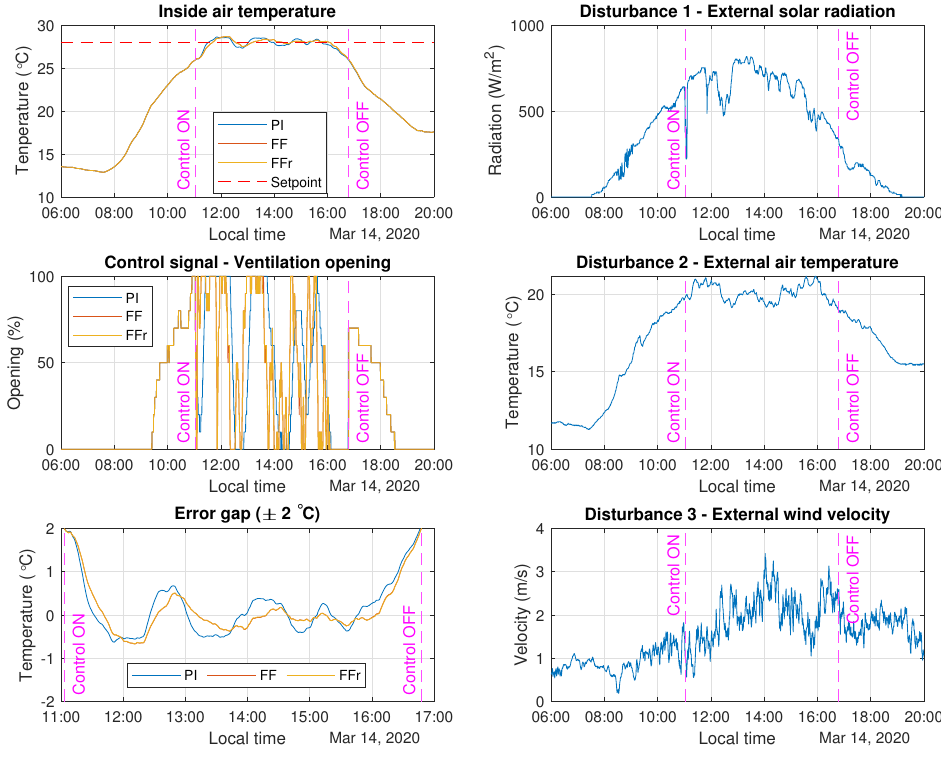
Figure 12. Results for simulation with data from 14 March 2020.